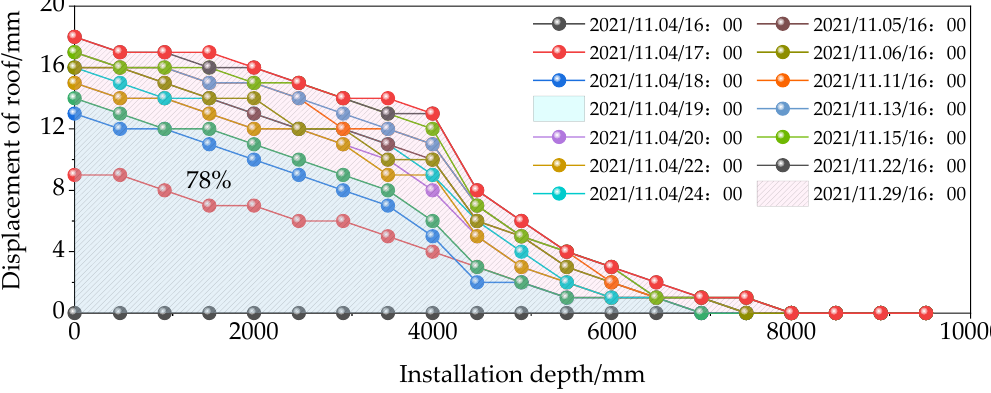
Figure 16. Measured curve of roof displacement during heading of 122110 auxiliary transportation roadway.